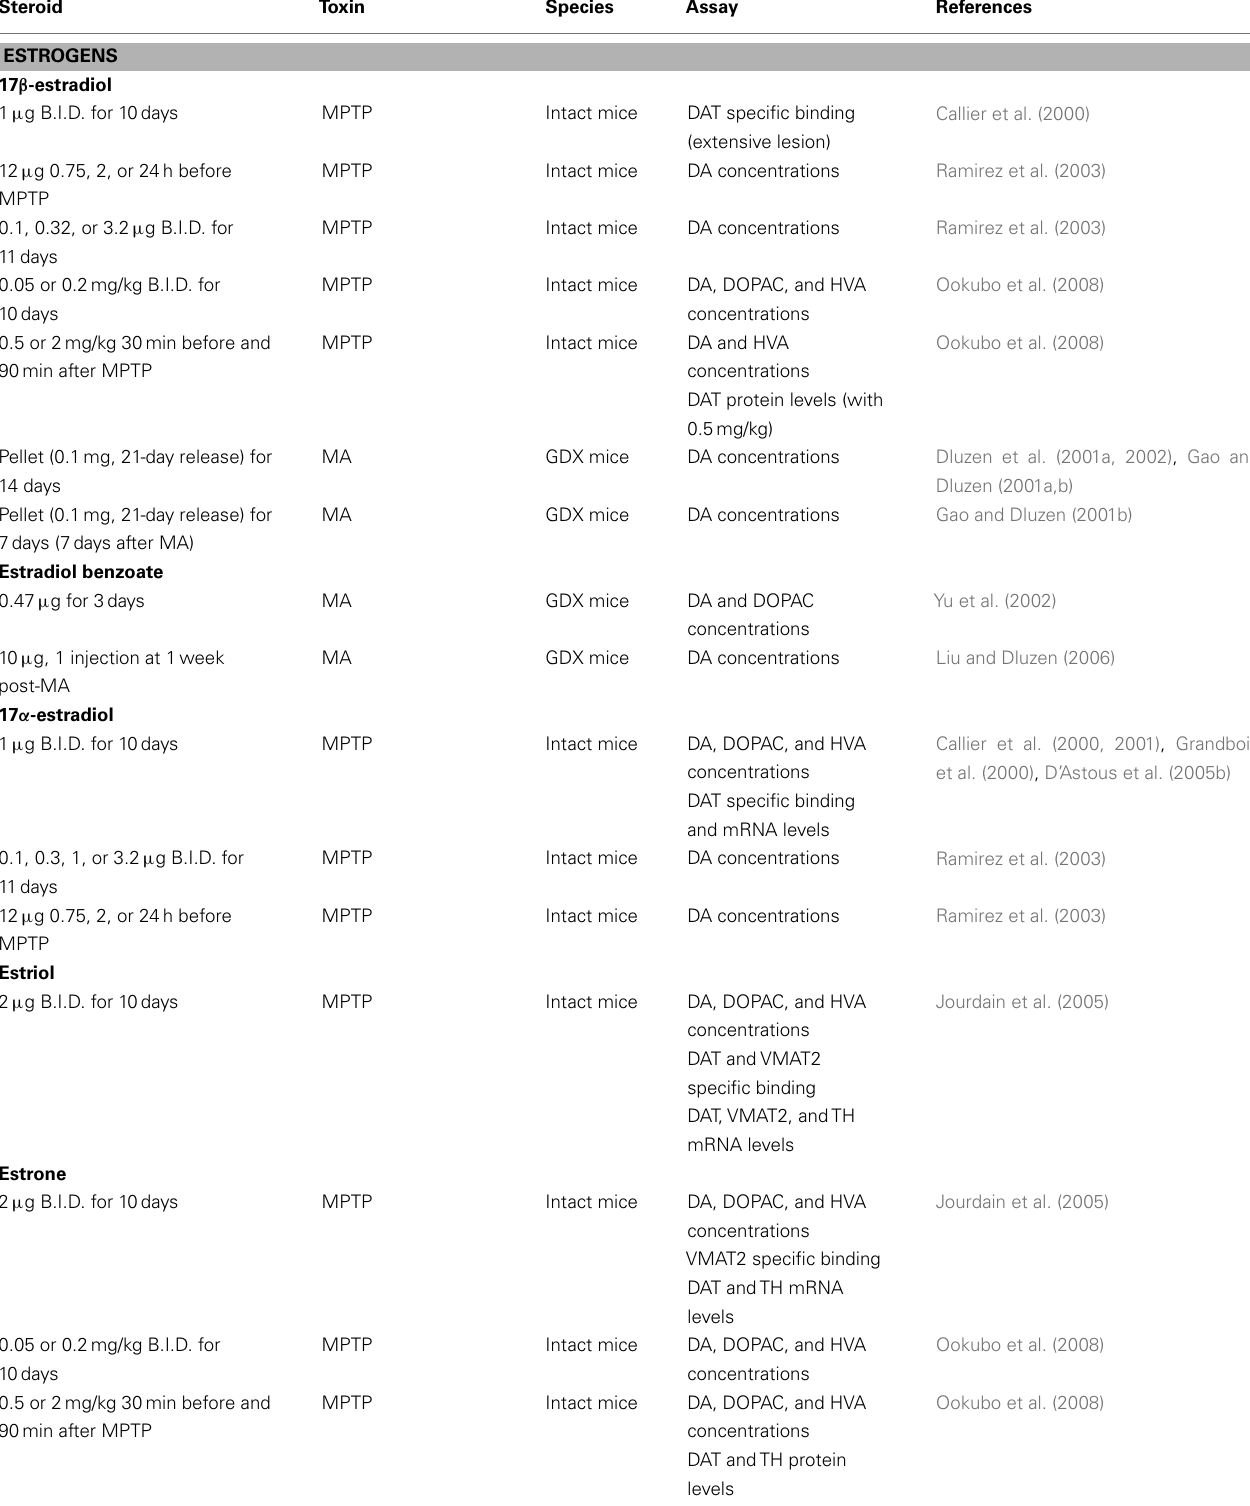
Table 4 | In vivo studies and neuroprotection in male rodents: studies showing no protection of DA markers.